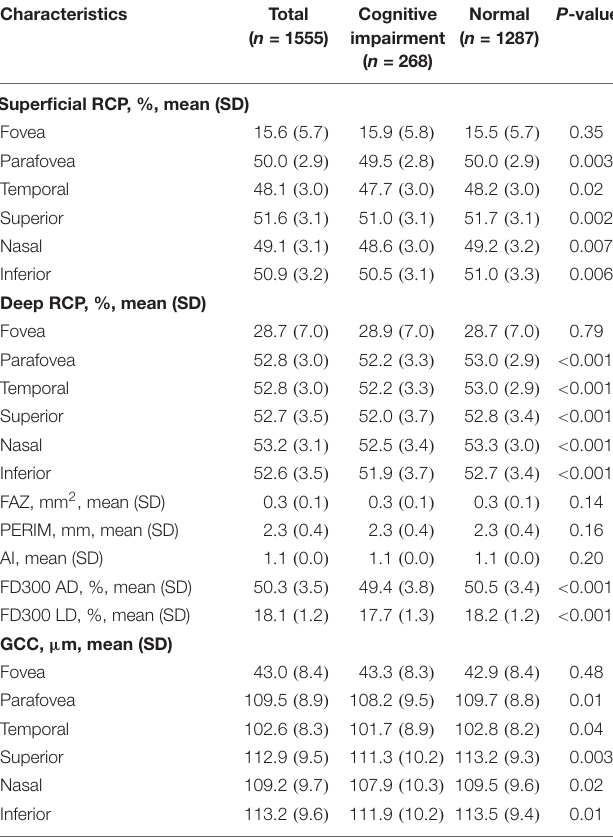
TABLE 2 | Ocular characteristics of eligible participants in the